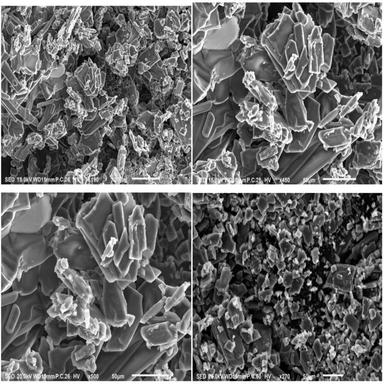
SEM images of the pure DMPI.